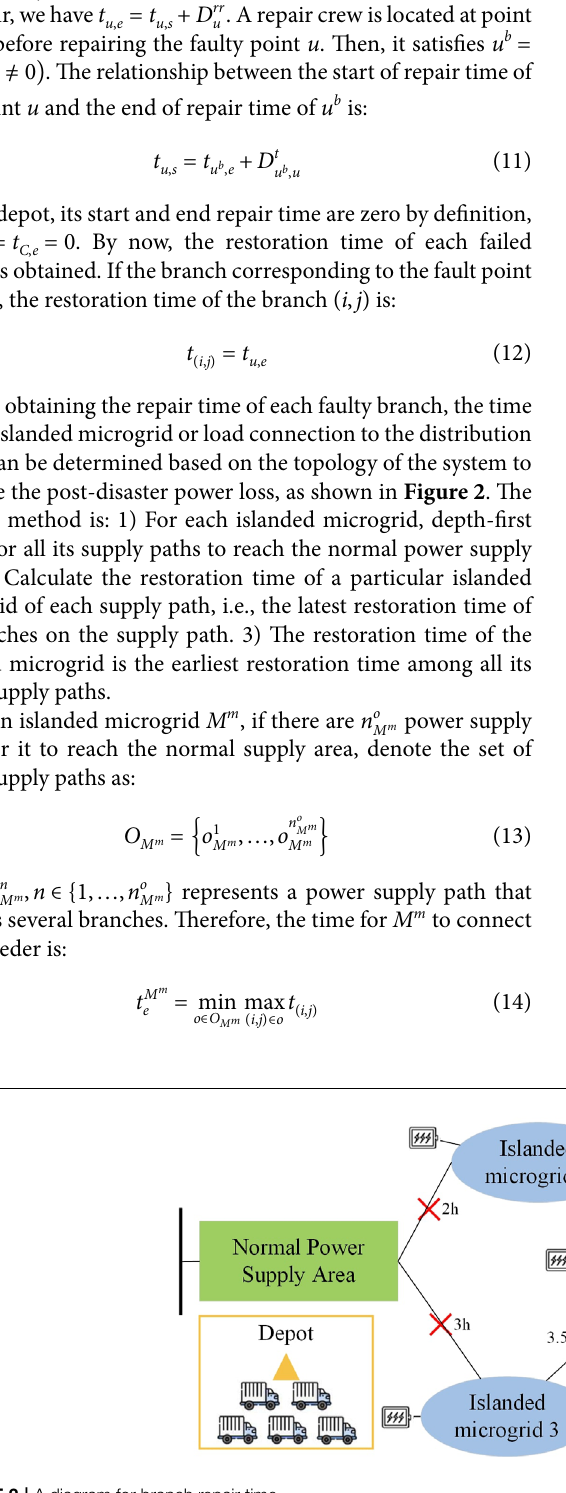
FIGURE 2 | A diagram for branch repair